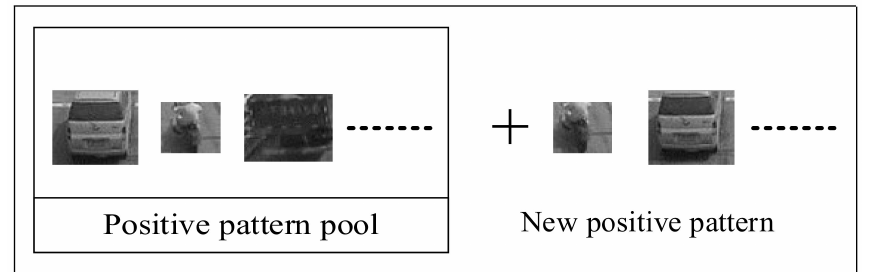
Figure 13. Storing method of the positive pattern pool.